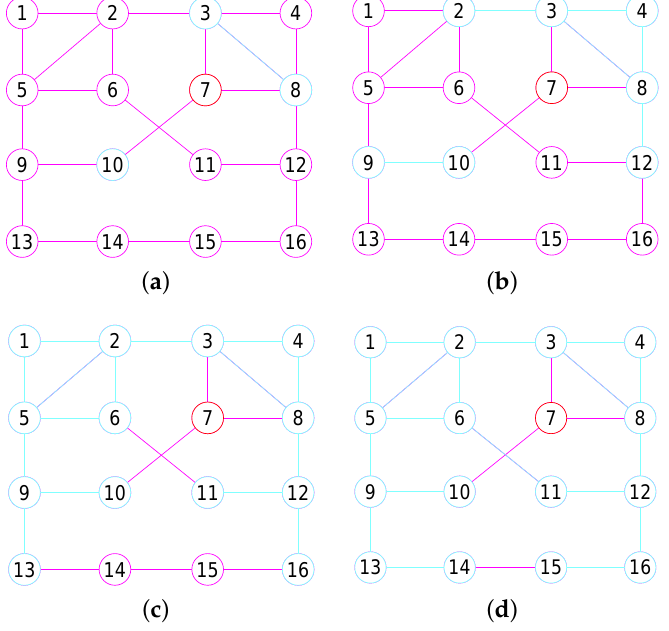
Figure 1. The 1, 2, 3, 4-neighborhood subgraph of vertex 7 in a graph G . ( a ) The 1-neighbor subgraph; ( b ) The 2-neighbor subgraph; ( c ) The 3-neighbor subgraph; ( d ) The 4-neighbor